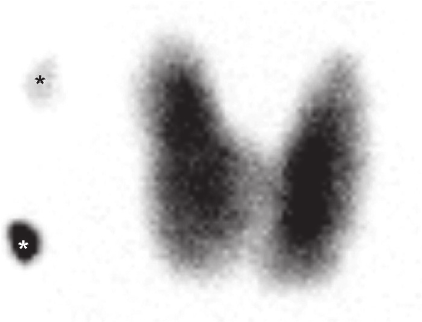
Figure 2: Radioiodine scan showing intense increased thyroid uptake, consistent with